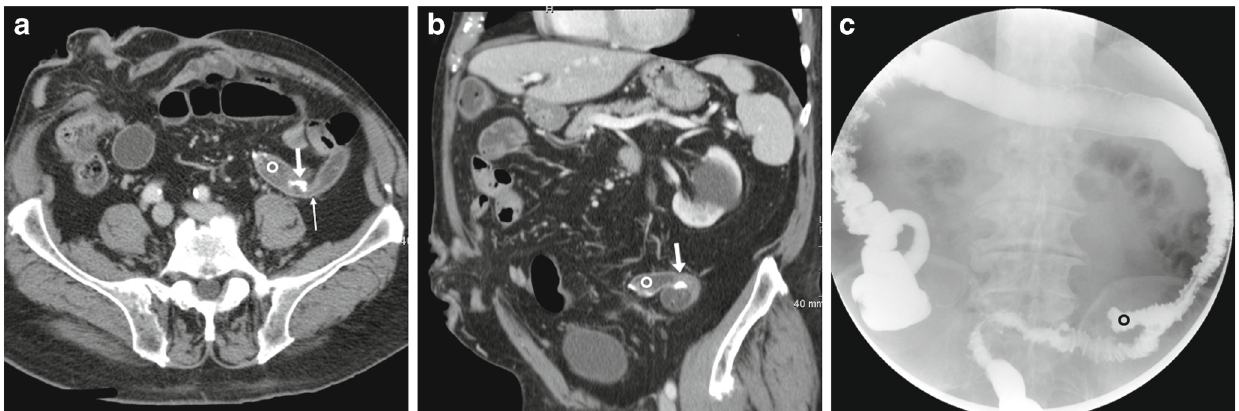
Fig. 9 Anastomotic recess and kinking in an 87-year-old male with a history of left hemicolectomy for descending colon carcinoma, complicated by anastomotic dehiscence. WE-MDCT ( a – b ) showed colo-colic anastomosis with staples (arrows), a blind-ending recess (o)